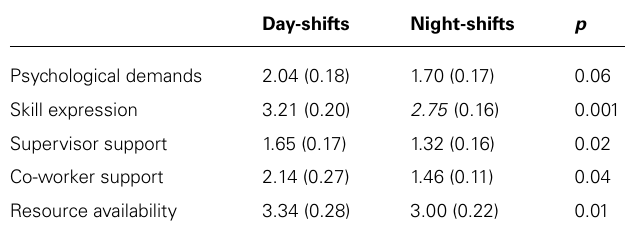
Table 2 | Operators’ job perception ( M ± SD) on day-shifts and night-shifts, followed by the p -value of